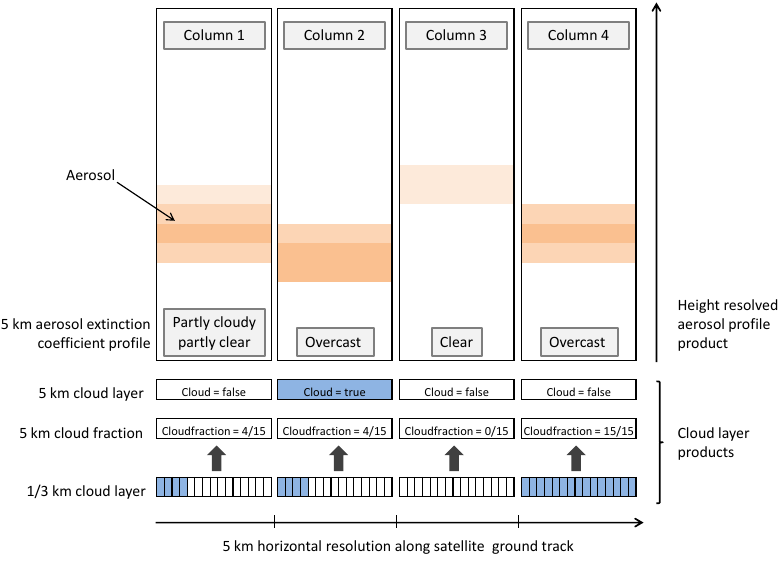
Figure 1. Illustration of the classification procedure of cloudy- and clear-sky aerosol extinction profiles. Only profiles where both the 1/3 and 5km cloud layer products indicate clear sky are classified as completely clear (column 3). Only profiles where either the 5km cloud layer product indicates a cloud or the 1/3km layer data indicate a 5km cloud fraction equal to 1 are considered completely cloudy or overcast (columns 2 and 4 respectively). All profiles where the 5km cloud layer product does not report a cloud, but the 5km cloud fraction is larger than zero but less than 1, are considered partly cloudy and partly clear (column